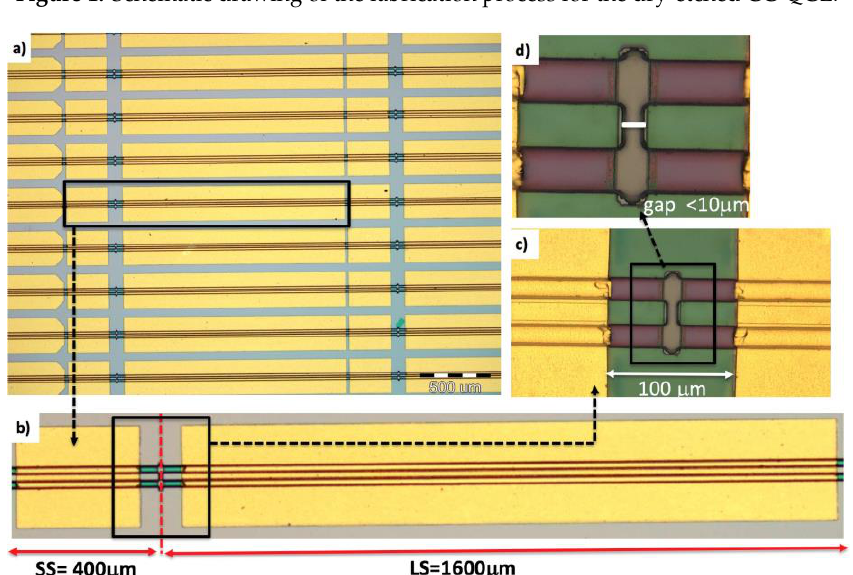
Figure 2. Optical microscope image of a part of processed epitaxial wafer of CC-QCL (a), close up on single chip (b) and close up on dry-etched optical-electric gap (c–d).